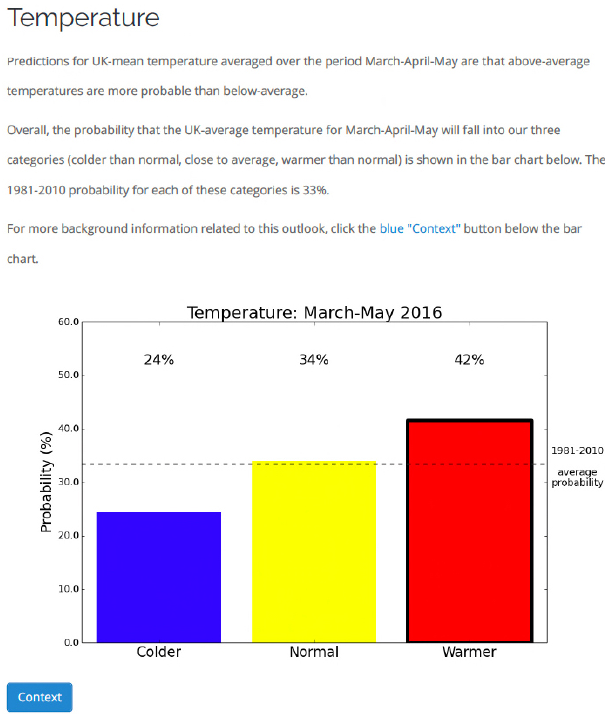
Figure 1. Seasonal climate forecast for temperature for March– May 2016 provided to the farmers through the